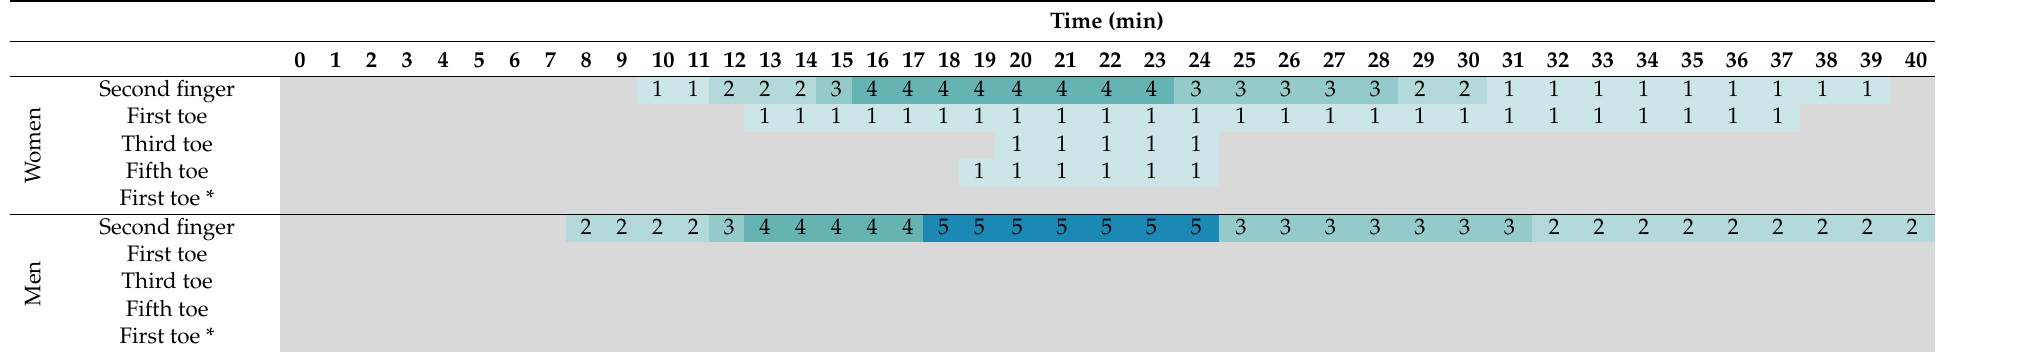
Table 2. Heat map presenting the number of participants that demonstrated a CIVD reaction for each minute of the cold immersion during exposure in the cool environment (16 ± 1 ◦ C). Colors indicate frequencies. Gray color indicates lack of CIVD.